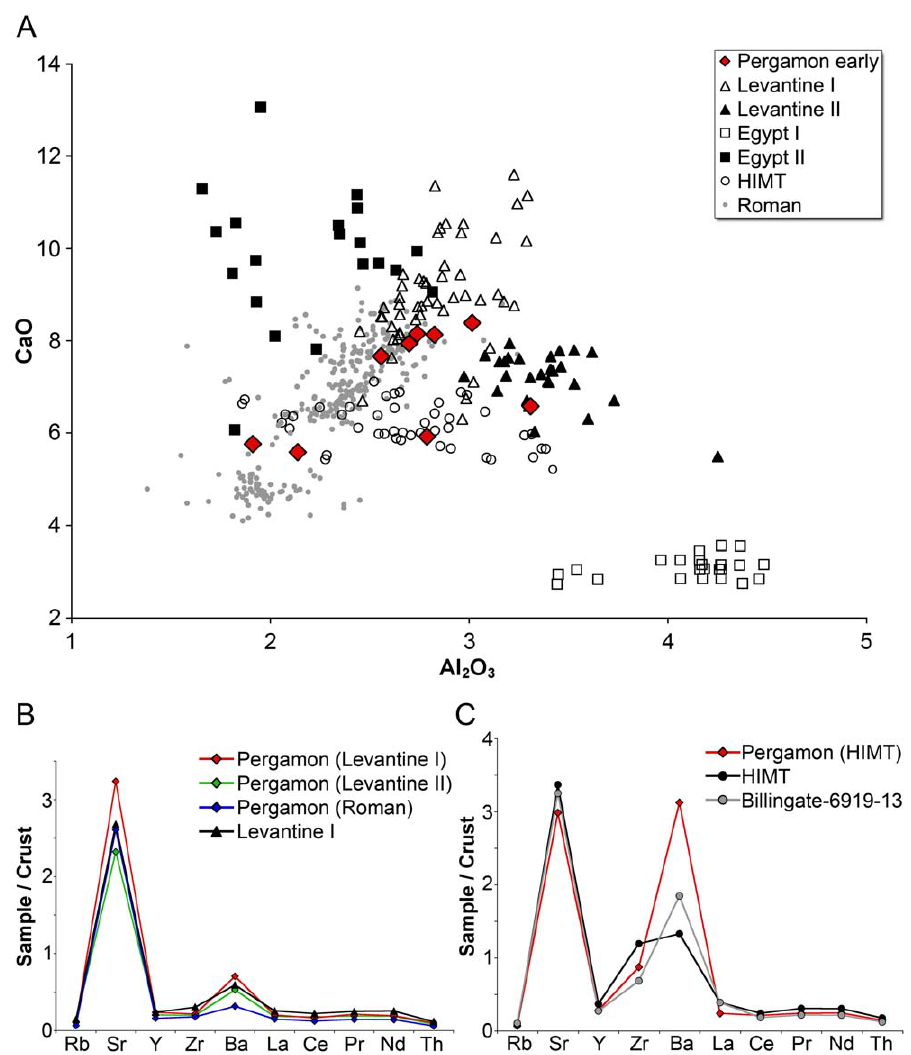
Figure 2. Early glasses from Pergamon in comparison with contemporary glass production groups. (A) The lime and alumina concentrations of the early Byzantine samples from Pergamon (red diamonds) were compared to the data of contemporary glass types (Roman glass from Italy [57–61]; Levantine I glass from Apollonia, Dor and Jalame; Levantine II glass from Bet Eli’ezer; HIMT glass from Billingsgate, Augusta and northern Sinai [by courtesy of Ian Freestone]; Egypt I and II glass [B. Gratuze, unpublished dissertation, University of Orleans, 1988: Analyse non destructive d’objets en verre par des mZˇthodes nuclZˇaires . Applicationˆ l’Zˇtude des estampilles et poids monZˇtaires islamiques ]). Five Pergamon samples overlap with Levantine I glass (empty triangles), one sample with Levantine II (black triangles), one with HIMT (circles), and two fragments with first- to fourth-century Roman glasses (grey circles). (B) Concentrations of trace elements of the early Pergamon glasses, normalized to the mean continental crust [43]. The mean value of five Levantine I samples from Pergamon (indicated in red), the Levantine II sample (green) and the average of the two Roman glasses from Pergamon (blue) are compared to the average trace element pattern of 9 Levantine I glasses (black) from Apollonia [29]. (C) The trace element composition of the HIMT glass from Pergamon (shown in red) exhibits a similar pattern as the average trace element distribution of HIMT glasses (black) and in particular with an HIMT glass from Billingsgate (grey; [29]).